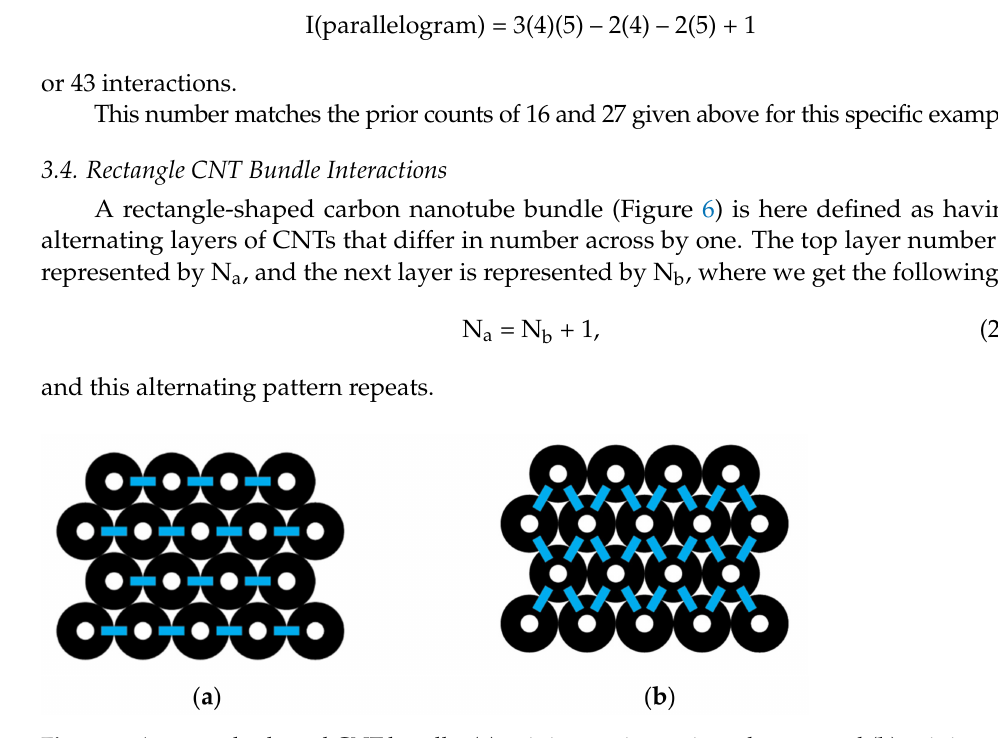
Figure 6. A rectangle-shaped CNT bundle: ( a ) pair interactions oriented across and ( b ) pair interac- tions oriented